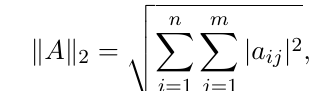
TABLE III: Distances between various numerical implementations of the probability